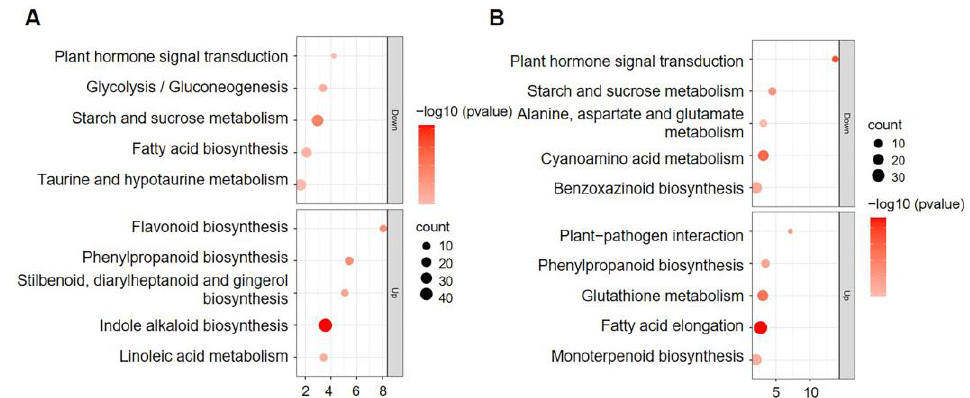
Figure 4. KEGG pathway enrichment analysis of differentially expressed genes between WT and smk7a at 12 and 20 DAP. ( A ) Top five KEGG enrichment pathways of the up- and down-regulated DEGs of smk7a compared to the WT at 12 DAP. ( B ) Top five KEGG enrichment pathways of up- and down-regulated DEGs of smk7a compared to the WT at 20 DAP. The Y -axis shows the KEGG pathway. The X - axis shows the −log 10 (q -value). The size of each dot represents the number of genes enriched in a particular pathway.